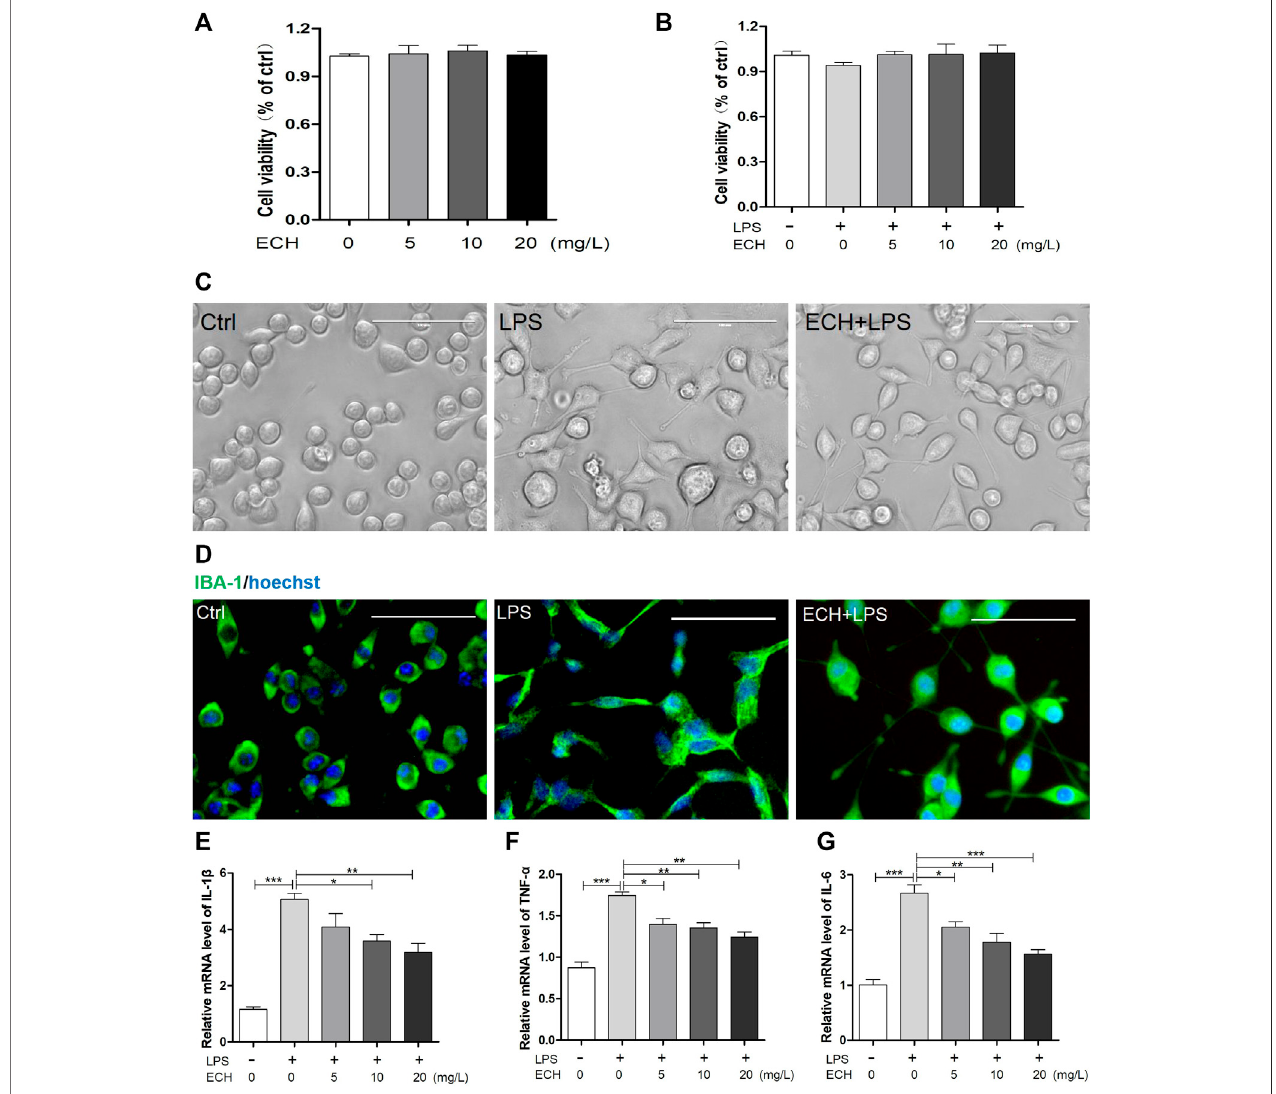
FIGURE5| ECHretrainedtheactivationofmicrogliaandsecretionofin fl ammatorycytokinesinLPS-inducedBV2cells. (A) BV2microglialcellsweretreatedwithECH(5,10,and 20 mg/L)for2 h,andcellviabilitywasmeasuredbyCCK8. (B) BV2microglialcellswerepretreatedwithECH(5,10,and20 mg/L)for2 handexposedtoLPS(1 μ g/ml)for6 h,andcell viabilitywasmeasured. (C) MorphologyofBV2cellsindifferentgroups. (D) Representativephotosofimmuno fl uorescencestainingofIBA-1inBV2cells. (E) TherelativemRNAlevelofIL- 1 β in different groups. (F) Relative mRNA level of TNF- α . (G) Relative mRNA level of IL-6. Values are presented as the mean ± SEM. * p < 0.05, ** p < 0.01, *** p < 0.001.